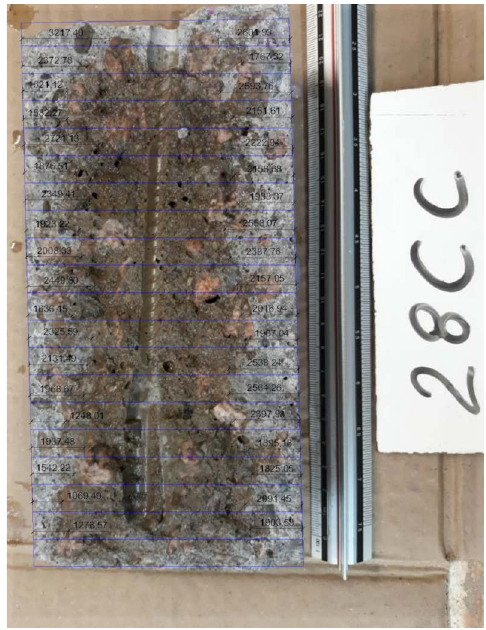
Figure 13. Chloride Penetration of samples with 28-day curing for 40 cycles.